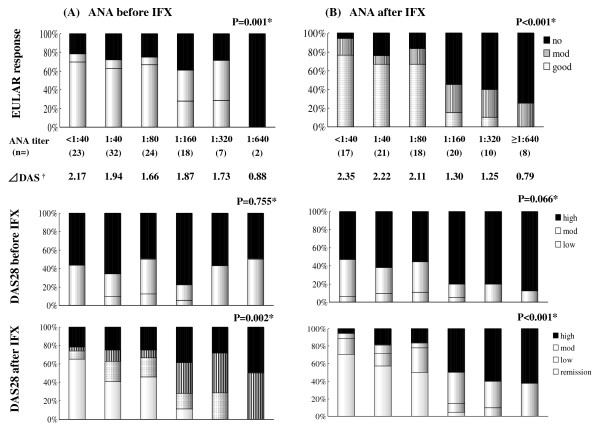
Correlation between ANA titer and clinical response to IFX. (a) Correlations between ANAs before starting therapy with IFX and clinical response to IFX. EULAR response (upper) and DAS28 after IFX (lower) were significantly different by ANA titer before IFX (P = 0.001 and 0.002, respectively, by Jonckheere-Terpstra trend test). The efficacy of IFX became worse as the ANA titer increased before starting IFX. (b) These clinical responses to IFX were analyzed with ANAs after starting IFX. The differences became more marked (P < 0.001 in both EULAR response (upper) and DAS 28 after IFX (lower), by the Jonckheere-Terpstra trend test). *Analyzed with the Jonckheere-Terpstra trend test. †Mean changes of DAS28 score before and after IFX.